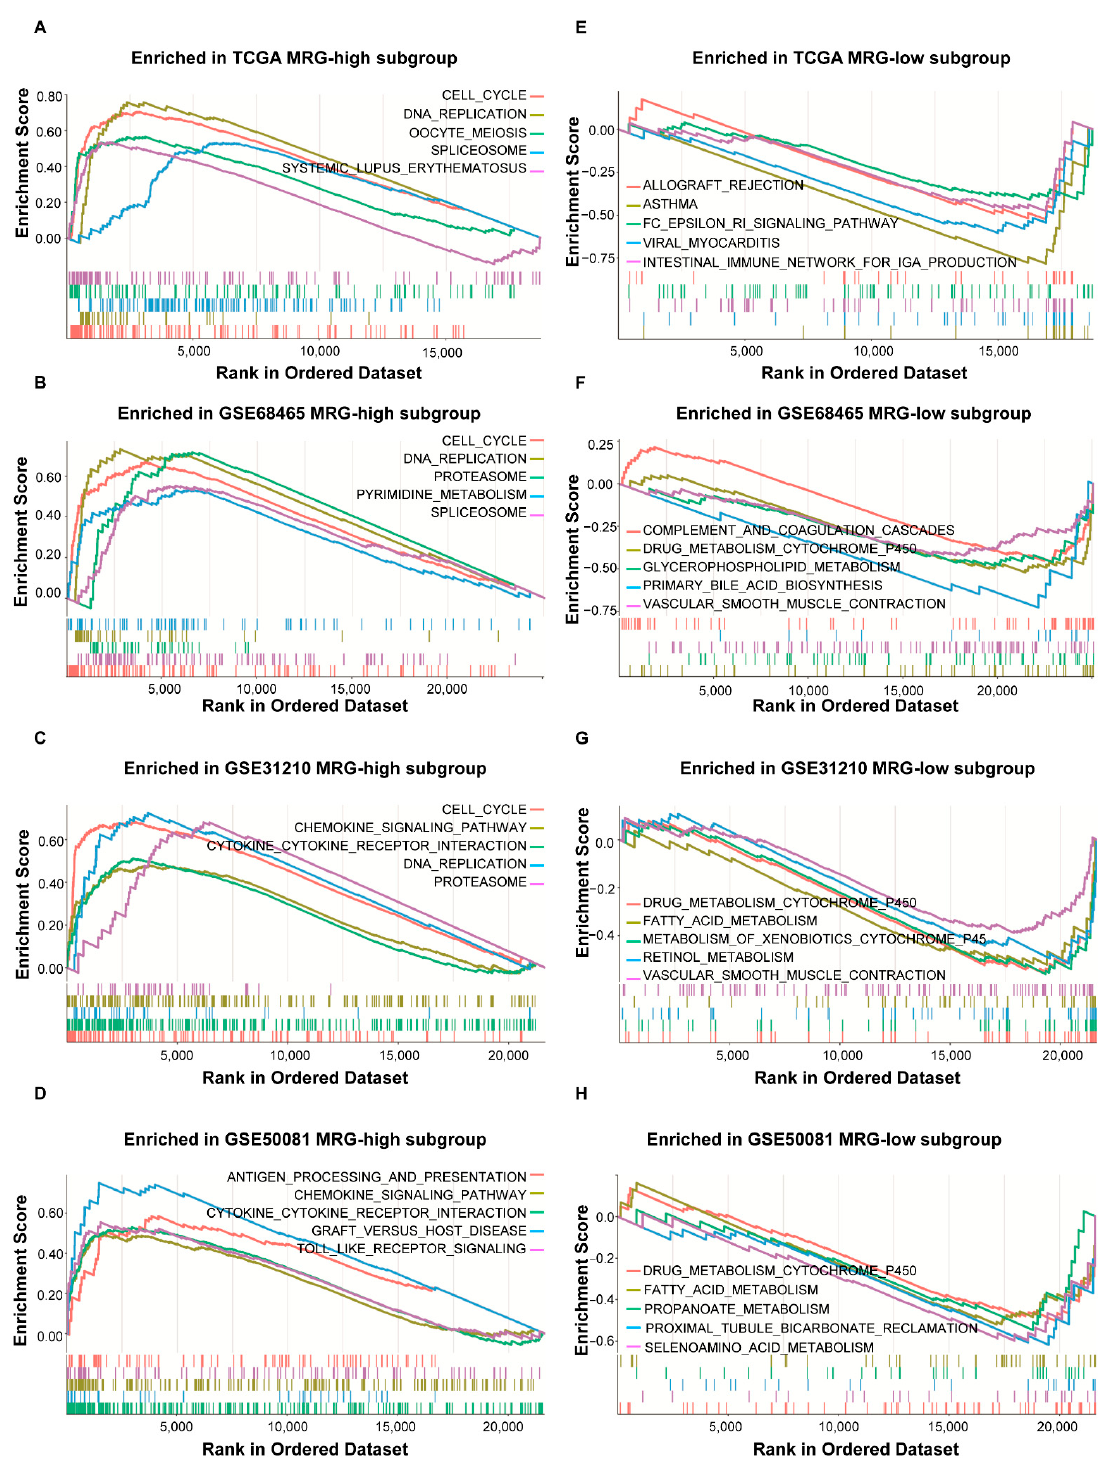
Figure 2. Gene Sets Enrichment Analysis of different MRG subgroups. ( A ) Gene Sets Enrichment Analysis (GSEA) of KEGG pathways in the TCGA MRG-high subgroups. ( B ) GSEA of KEGG path- ways in the GSE68465 MRG-high subgroups. ( C ) GSEA of KEGG pathways in the GSE31210 MRG- high subgroups. ( D ) GSEA of KEGG pathways in the GSE50081 MRG-high subgroups. ( E ) GSEA of KEGG pathways in the TCGA MRG-low subgroups. ( F ) GSEA of KEGG pathways in the GSE68465 MRG-low subgroups. ( G ) GSEA of KEGG pathways in the GSE31210 MRG-low subgroups. ( H ) GSEA of KEGG pathways in the GSE50081 MRG-low subgroups; p <